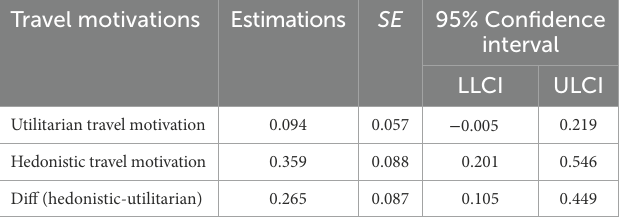
TABLE 2 Comparison of continuous mediation effects in different scenarios under the moderation of travel motivation. Travel